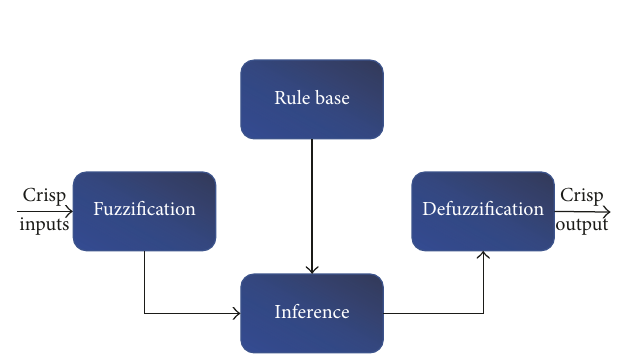
Figure 4: Fuzzy structure.